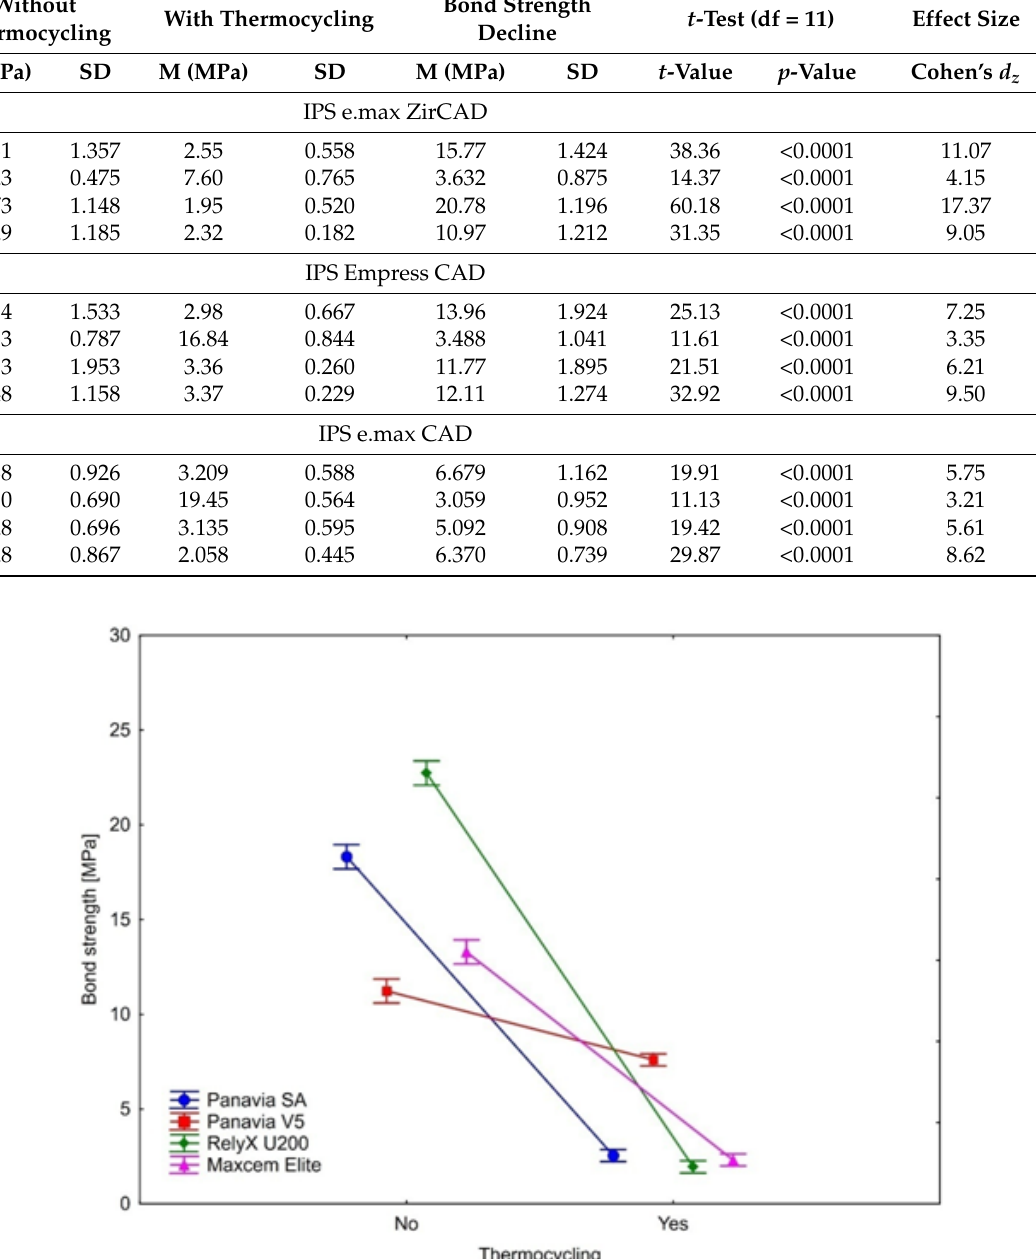
Figure 4. The effect of thermocycling on luting cement bond strength to IPS e.max ZirCAD. Vertical bars denote 0.95 confidence intervals around the mean values.